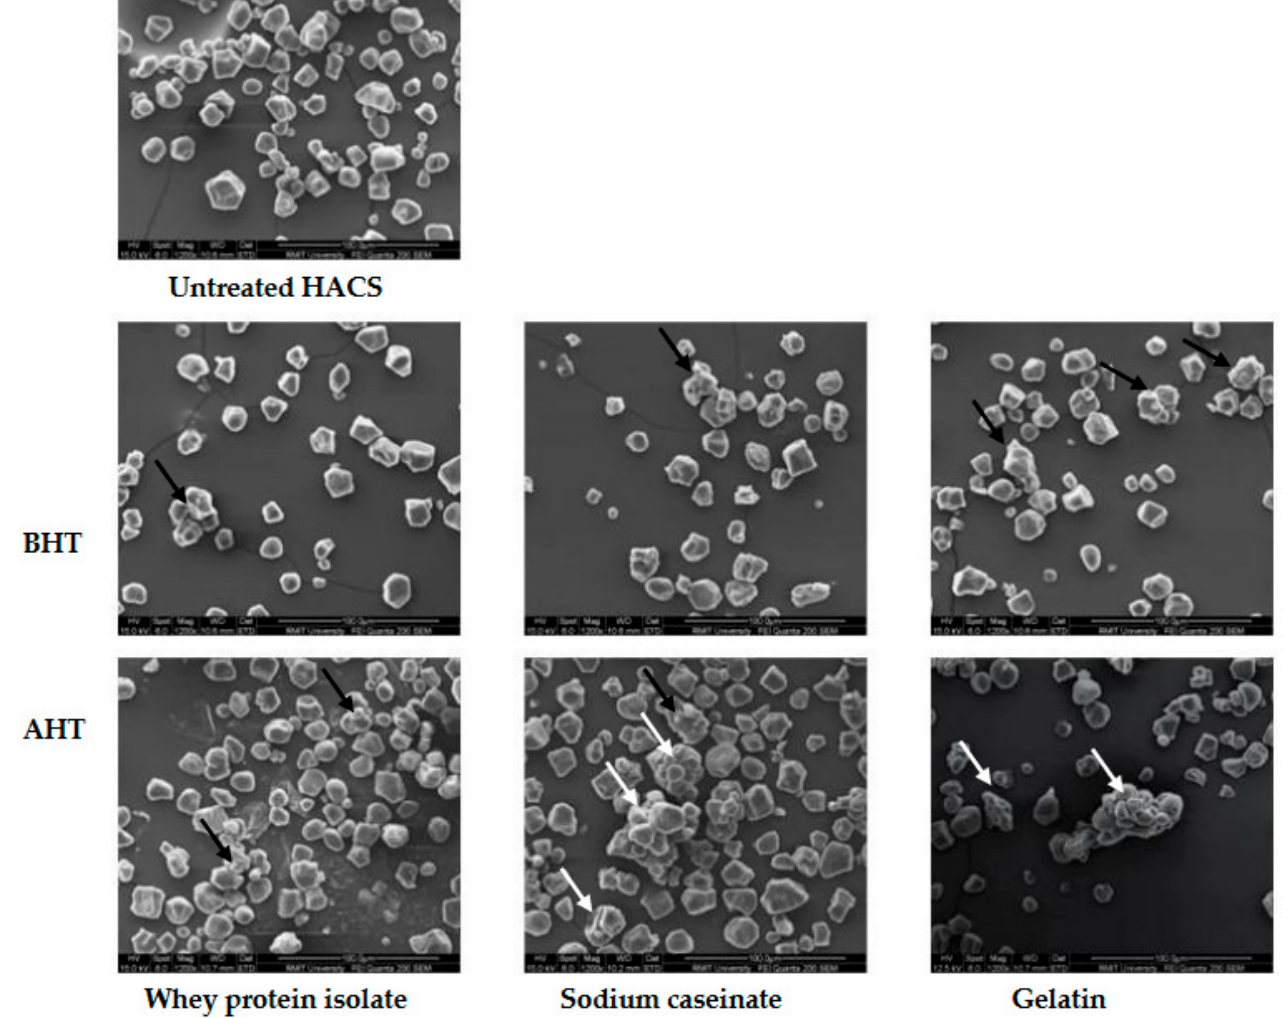
Figure 4. Scanning electron micrographs captured for high amylose corn starch (HACS) and in combination with proteins prepared by the wet mixing method before and after dry heat treatment under 1000 × SEM. Arrows on the micrographs show that the protein coated the aggregated granules.